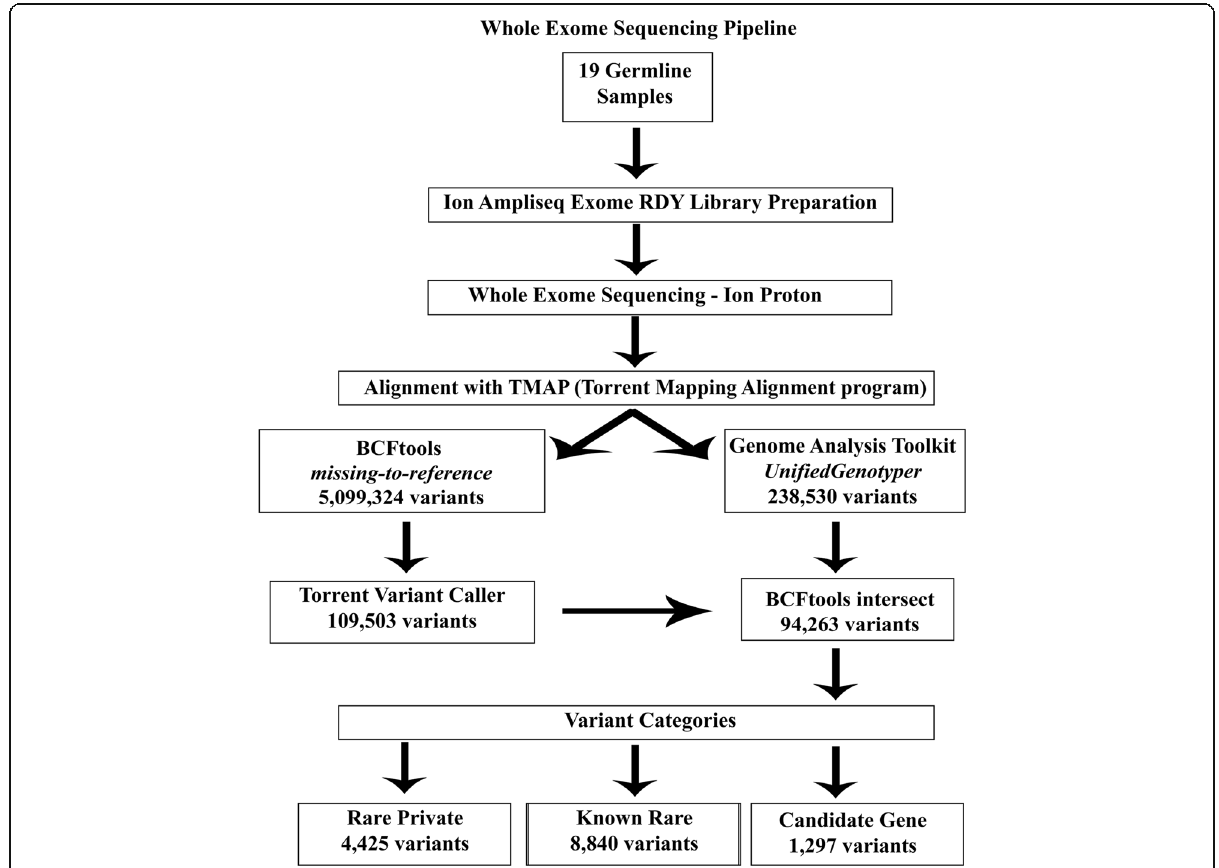
Fig. 2 Bioinformatics flowchart for variant calling in pedigree